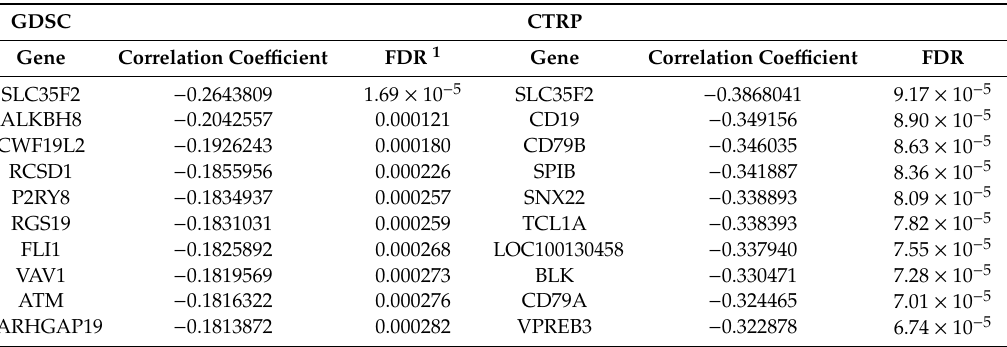
Table 2. Top 10 genes whose expression is most strongly inversely correlated with the YM155 AUC in the Genomics of Drug Sensitivity in Cancer (GDSC) database and the Cancer Therapeutics Response Portal (CTRP) as indicated by the Pearson correlation coefficient.